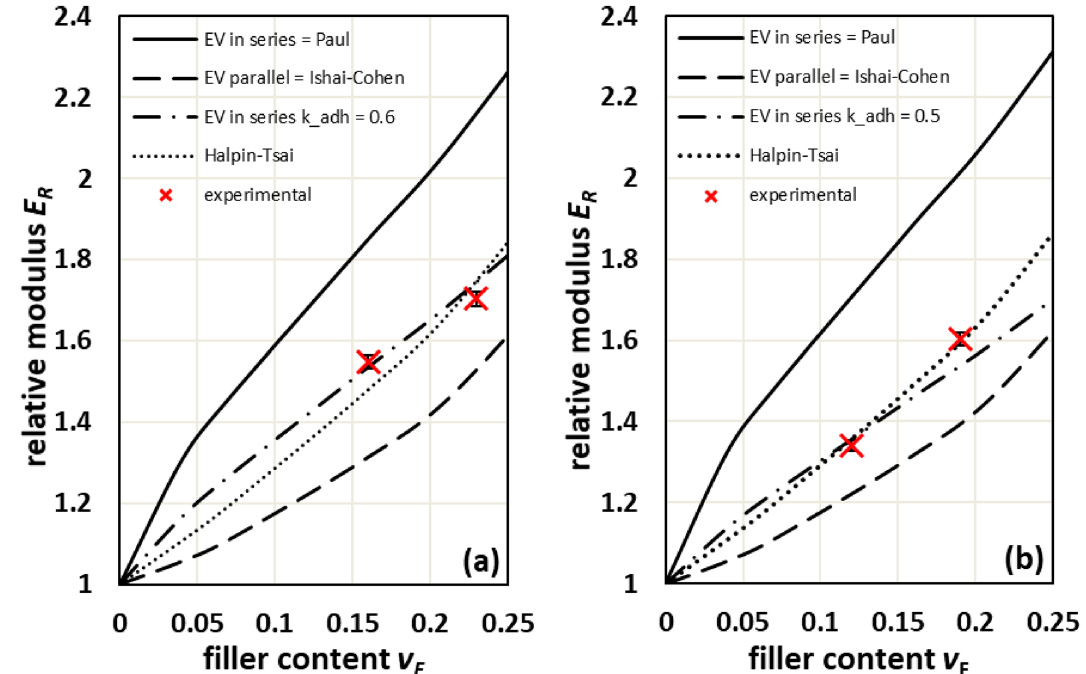
Figure 4. Comparison of relative Young’s moduli calculated according to Ishai-Cohen, Paul, Halpin–Tsai with ξ = 2, and EV for k adh = 0.5 and 0.6 (lines) with measured ones (symbols) for ( a ) PA66 and ( b ) PBT.